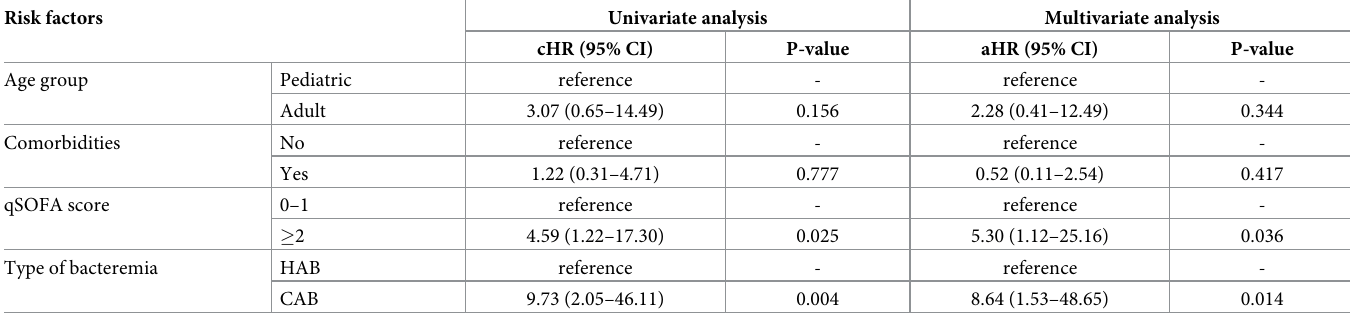
Table 3. Univariate and multivariate Cox regression analysis of risk factors for mortality in patients with hematological malignancies and Aeromonas sobria bacteremia.